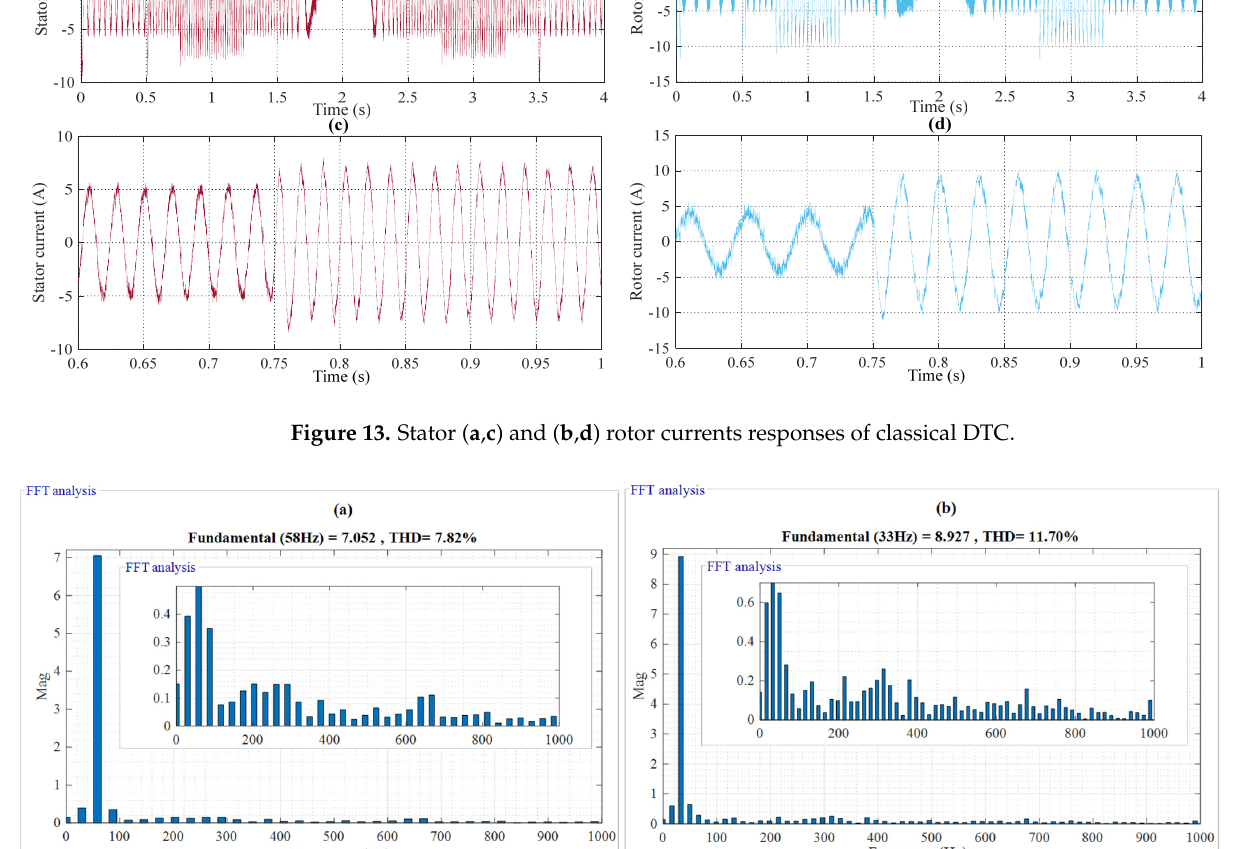
Figure 14. Stator ( a ) and rotor ( b ) THD of classical DTC.